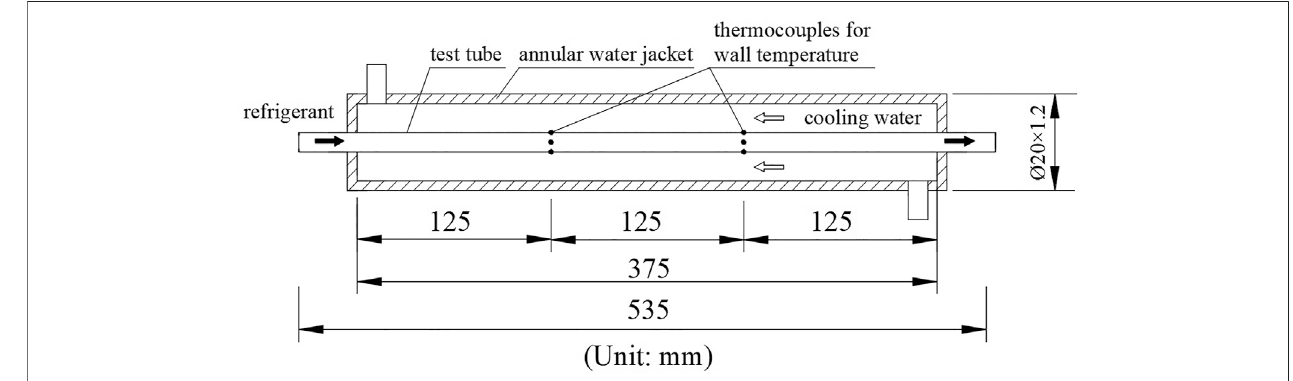
FIGURE 2 | Schematic diagram of the test section.